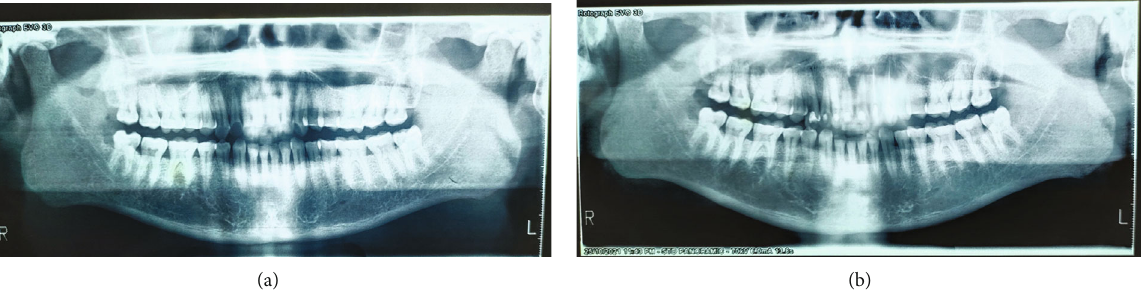
Figure 2: OPG of case 1 obtained at 15 days ’ gap.